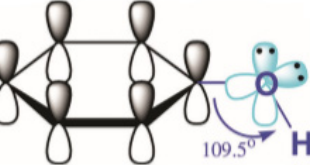
Figure 3. The chemical structure of phenol. Reproduced from Ref. [12]. Copyright 2017 IntechOpen. Phenol has a cross-sectional area of 4.20 × 10 − 10 m, a volume of 87.8 × 10 − 6 m 3 /mol, a saturated concentration in water of 912 mol/m 3 , and pKa of 9.99 [13]. Phenol is classified as an acid that is weaker than carbonic acid (pKa of carbonic acid is 6.4) but stronger than water (pKa of water is 15.7). Substituted phenol derivatives do not dissolve well in water (solubility does not exceed 30 g/L), but unsubstituted phenols are relatively soluble in water (83 g/L). Alkyl and halogen groups can be used as substituents to increase